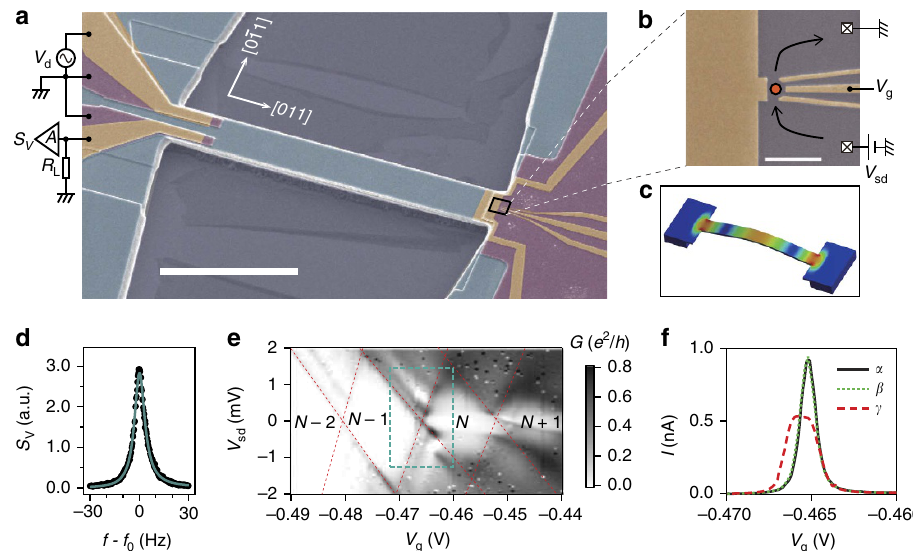
Figure 1 | Hybrid mechanical resonator quantum dot system. ( a ) False-colour scanning electron microscope (FCSEM) image of the hybrid device along with the measurement setup (scale bar, 20 m m). A doubly clamped electromechanical resonator of 50 m m length, 6 m m width and 1 m m thickness is fabricated along the 011 ½ (cid:7) crystal axis of GaAs. ( b ) FCSEM image of the Schottky gate electrodes defining the quantum dot at the right clamping point of the mechanical resonator (scale bar, 1 m m). Application of negative bias voltage to these gates depletes the underlying two-dimensional electrons and confines a few electrons within a small spacial area of o 300 (cid:2) 300nm 2 (red circle in b ). ( c ) Finite element method simulation of the mechanical strain associated with the fundamental flexural mode’s motion, showing the maximum strain at the clamping points. ( d ) The frequency response voltage power spectrum S V of the electromechanical transducer around the centre frequency f 0 ¼ 1664699.2Hz of the fundamental flexural mode along with a Lorentzian fit (solid line). ( e ) A plot of the differential conductance of the quantum dot as a function of V g and V sd showing typical Coulomb diamonds as indicated by the red dashed lines. In each diamond, the number of electrons N in the QD are changed. In this study, we focus on the Coulomb peak enclosed by the blue square. ( f ) A Coulomb peak with the mechanical resonator under three different actuation conditions; a , no actuation; b , off-mechanical resonance actuation with V d ¼ 150 m V at f ¼ f 0 (cid:3) 100Hz; g , on-mechanical resonance actuation with V d ¼ 150 m